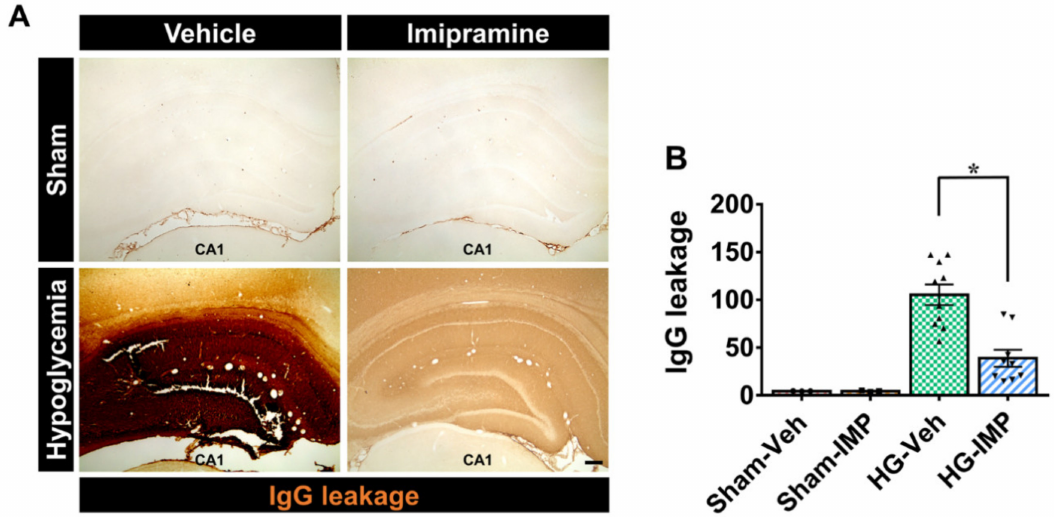
Figure 5. Administration of imipramine reduced blood–brain barrier (BBB) disruption after